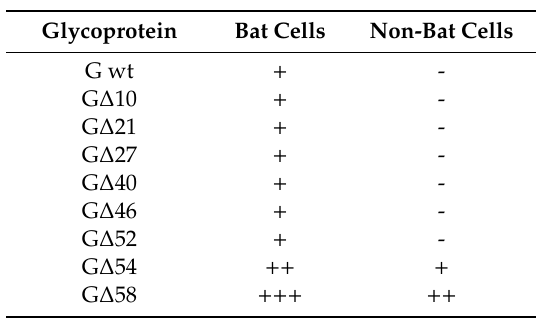
Table 2. Syncytium formation following coexpression of GhV F and truncated G